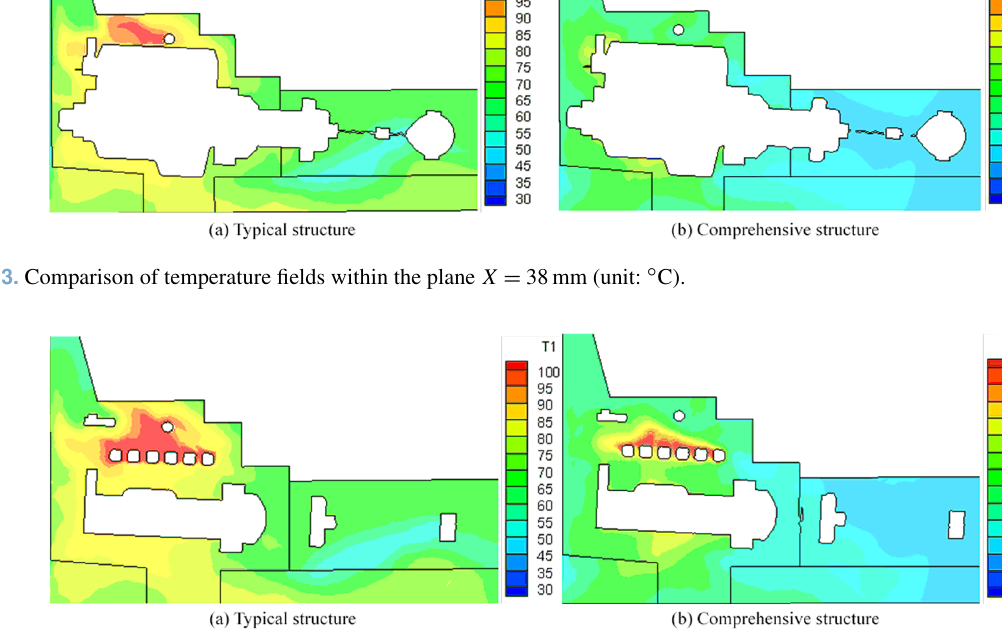
Figure 14. Comparison of temperature fields within the plane X = 148mm (unit: ◦